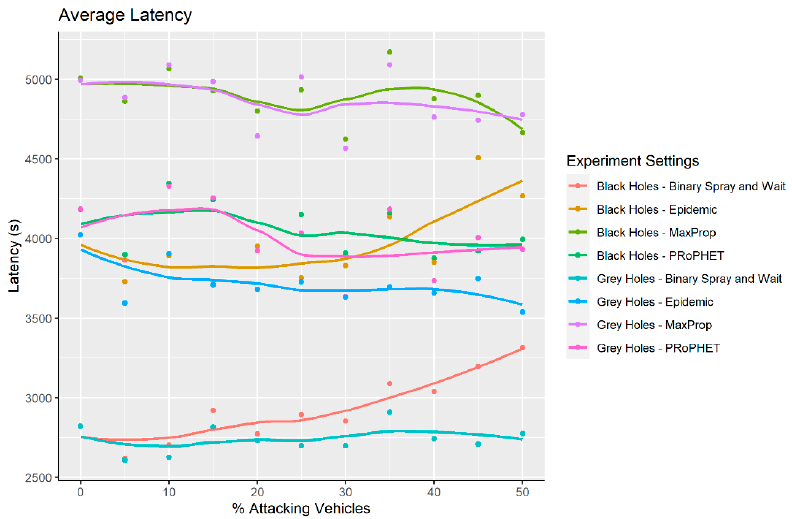
Figure 8. The average latency across multiple experiment